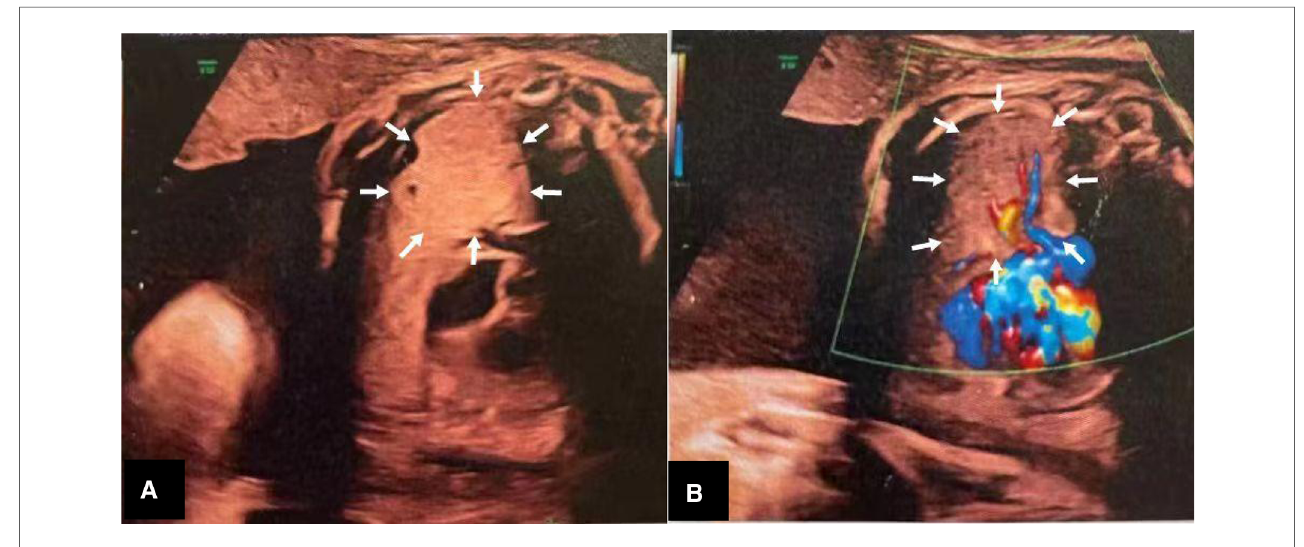
FIGURE 1 ( A , B ) Prenatal ultrasound showing a solid lung mass (arrows) with cystic